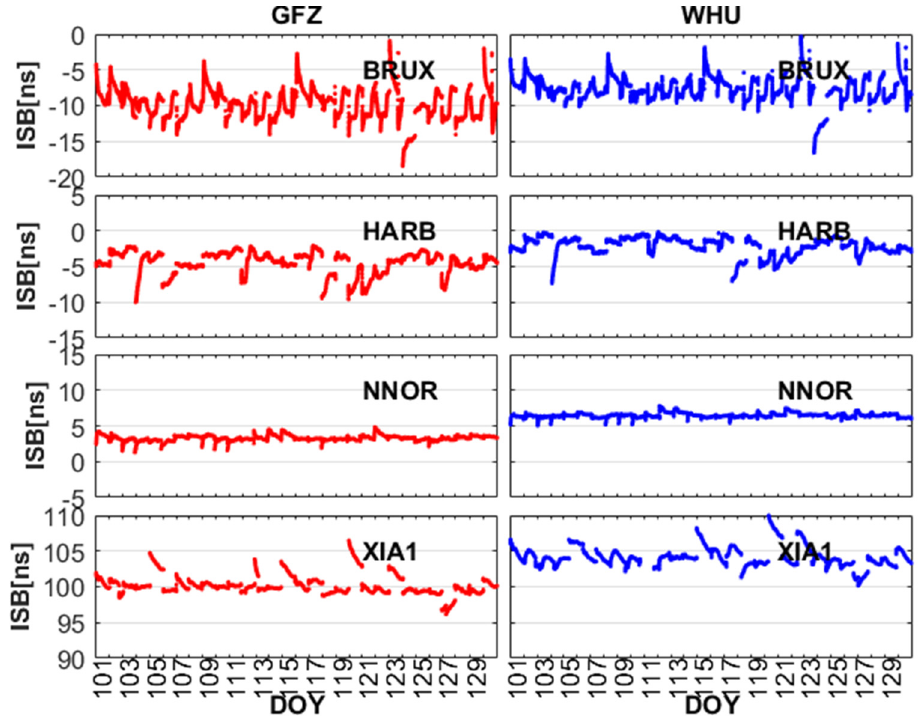
Figure 5. The inter-system bias (ISB) between BDS-2 (B1I/B3I) and BDS-3 (B1I/B3I) for Helmholtz Centre Potsdam German Research Center for Geosciences (GFZ) and Wuhan University (WHU) from DOY 101 to 130, 2020.